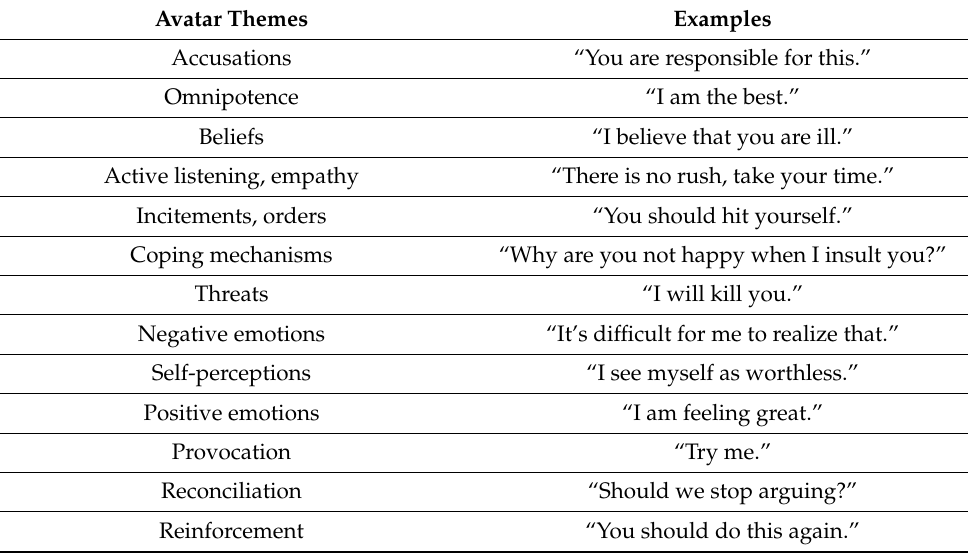
Table 1. Avatar interactions themes as per Beaudoin et al. 2021.